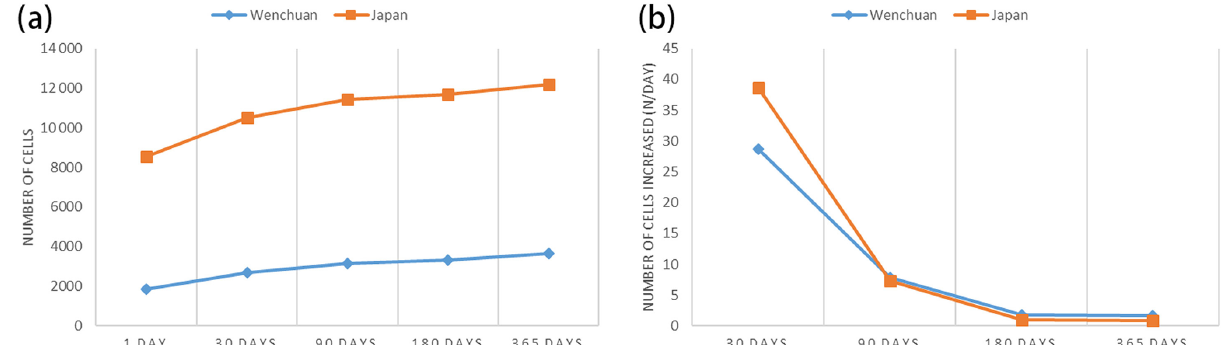
Figure 16. The curve of the aftershock hysteresis effect (predicted aftershock pattern). Panel (a) shows the number of cells with aftershocks predicted at different timescales, and panel (b) shows the increment of cells with aftershocks at each timescale.